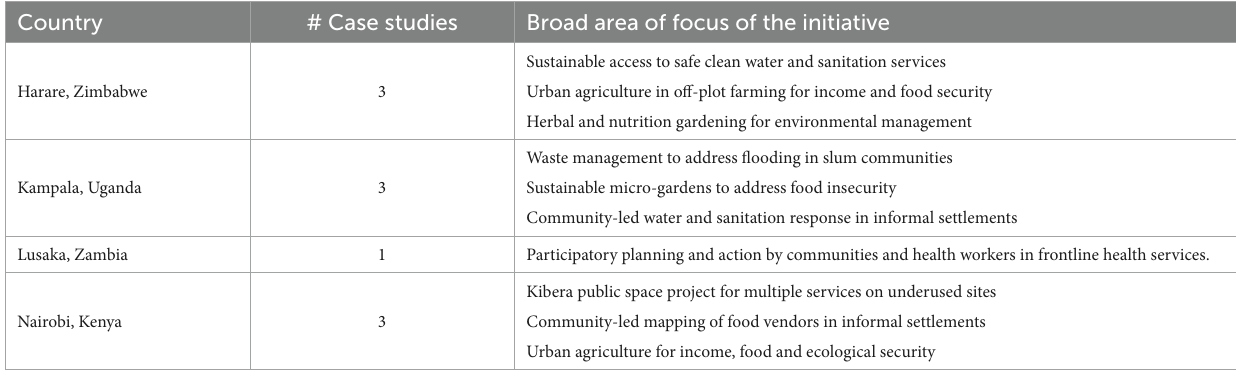
TABLE 2 Case studies by city and areas of work.